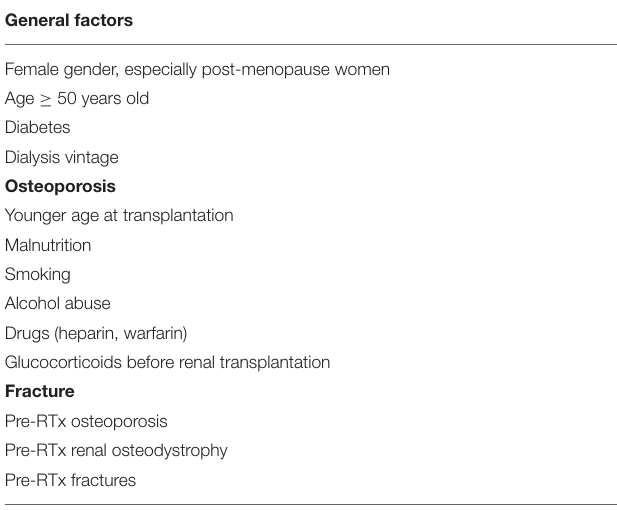
TABLE 1 | Pre-transplant factors associated with MBD development after RTx. General